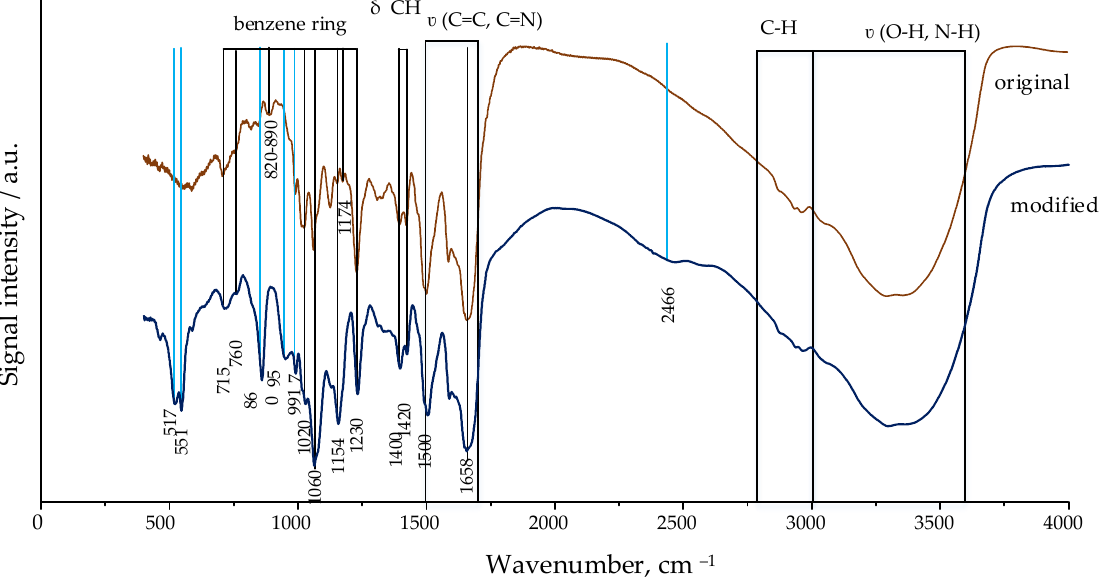
Figure 8. FTIR spectra of vancomycin: original, and after interaction with Na 2 HPO 4 ·12H 2 O. On the surface of the vancomycin particles, when exposed to sodium hydrophosphate salt, surges formed (Figure 9).